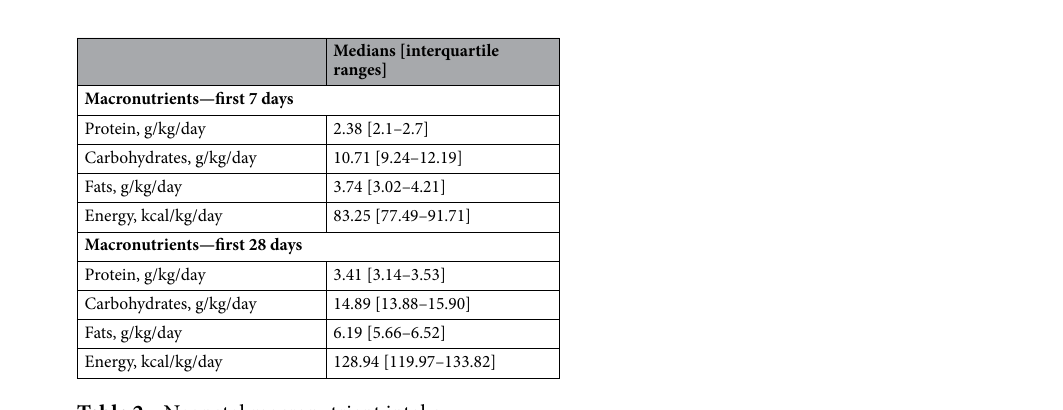
Table 2. Neonatal macronutrient intake.